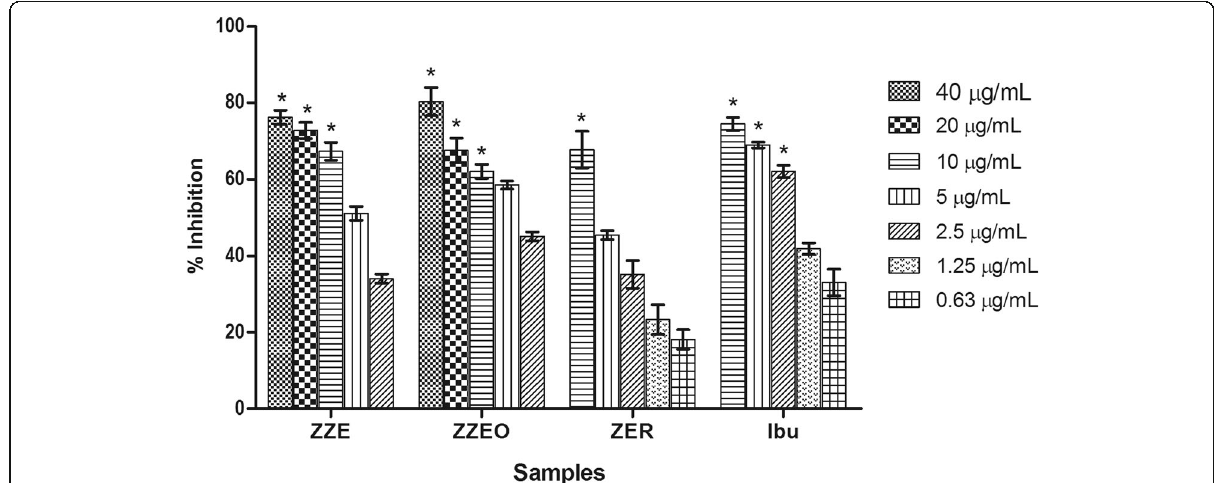
Fig. 3 Percentage inhibition of test samples on PMN chemotaxis presented as mean ± SEM (n = 3). Data were analyzed by one-way ANOVA followed by Dunnet ’ s post hoc test. Significance of differences with respect to control: * p <